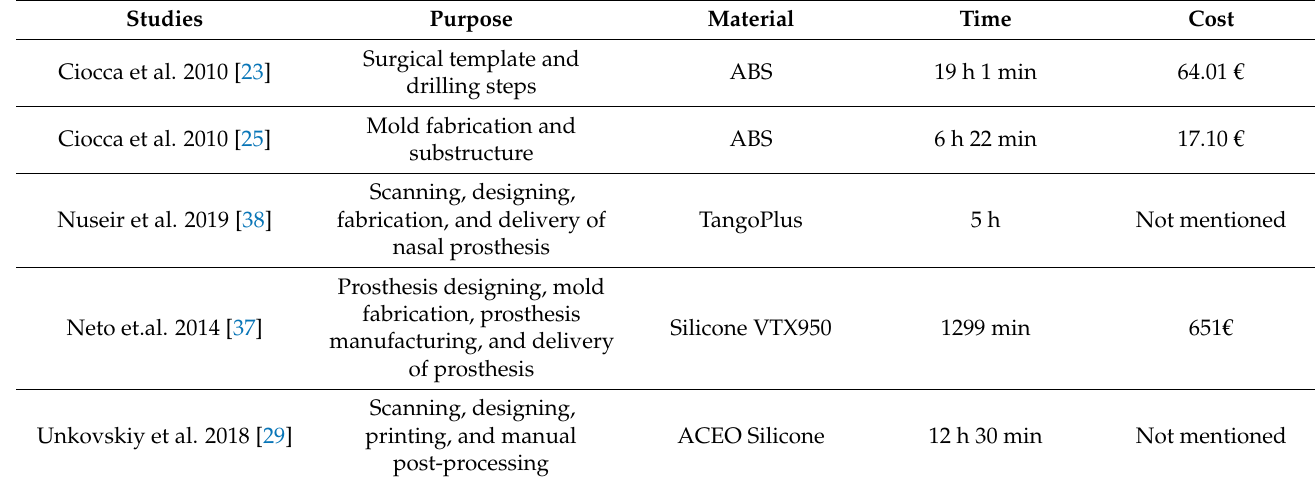
Table 6. Time and cost estimation for various steps involved during the fabrication of nasal prostheses through digital workflow.